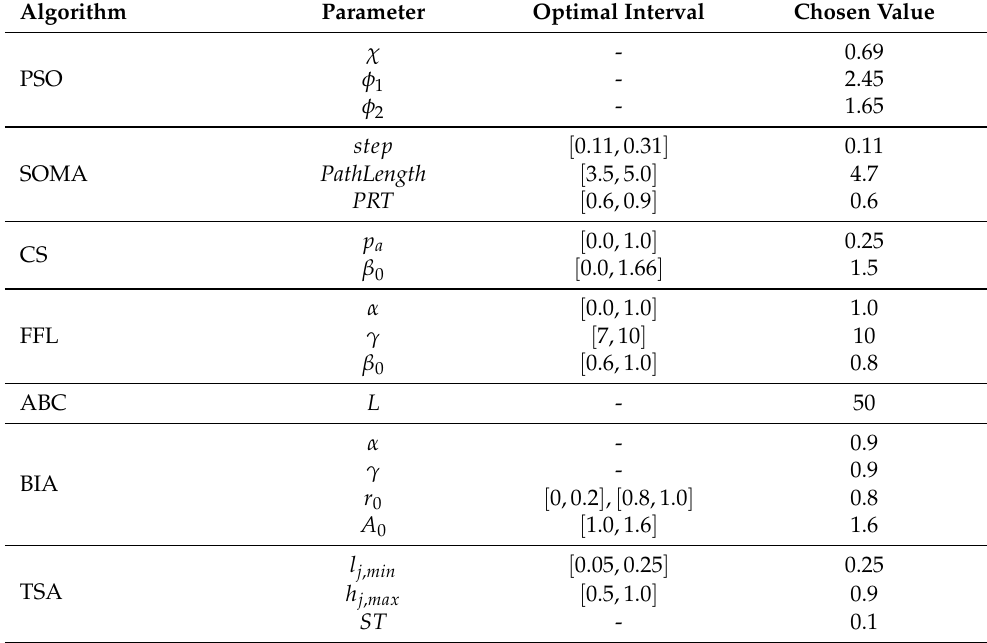
Table 1. Parameters